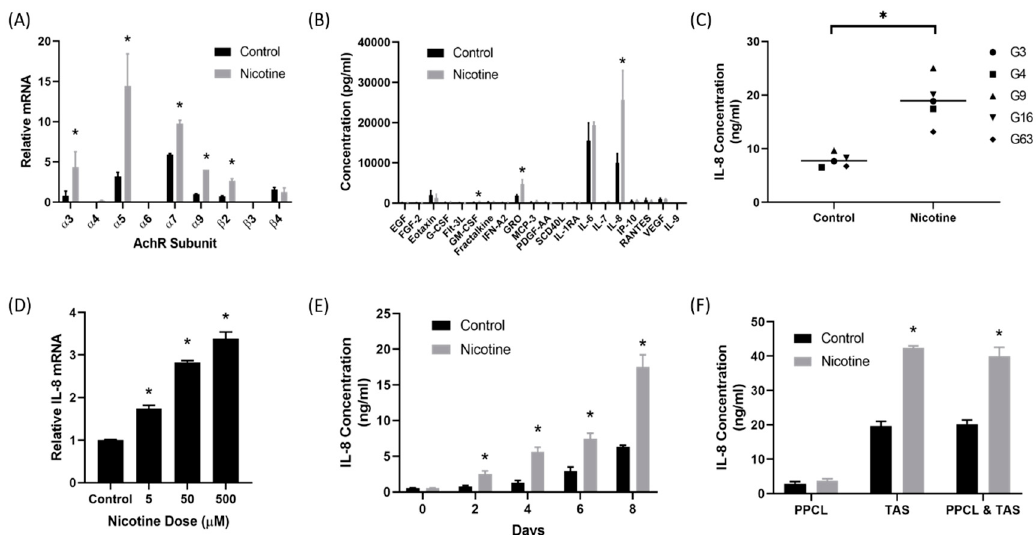
Figure 1. Nicotine induced interleukin 8 (IL-8) secretion from the tumor associated stroma. ( A ) qRT-PCR analysis demonstrated that nicotinic acetylcholine receptor (AchR) subunits were expressed by patient-derived tumor associated stroma (TAS) cells. Treatment of TAS cells with nicotine (50 µ M) upregulated (AchR) subunit expression compared to control. ( B ) A 41 protein multiplex assay detected significantly elevated levels of IL-8 secretion from TAS cells treated with 50 µ M of nicotine compared to control from three patient-derived TAS cell lines. ( C ) ELISA confirmed that nicotine-treated TAS cells had significantly elevated secretion of IL-8 in five di ff erent patient-derived TAS cells. ( D ) IL-8 secretion by TAS cells increased with increased treatment dose. ( E ) IL-8 secretion by TAS cells increased with increased duration of treatment. ( F ) Nicotine-treated primary pancreatic cancer cell lines (PPCL) did not have elevated IL-8 levels. Nicotine-treated TAS cells had significantly elevated IL-8 levels. PPCL and TAS in co-culture had significantly elevated IL-8 secretion.